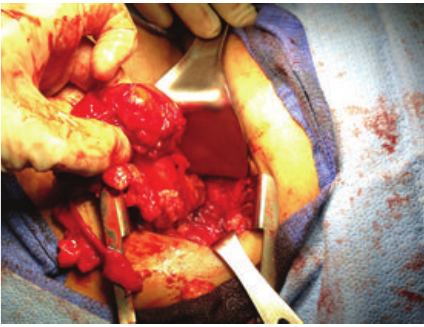
Figure 4: Dissection of the hernia sac of the surrounding subcuta- neous